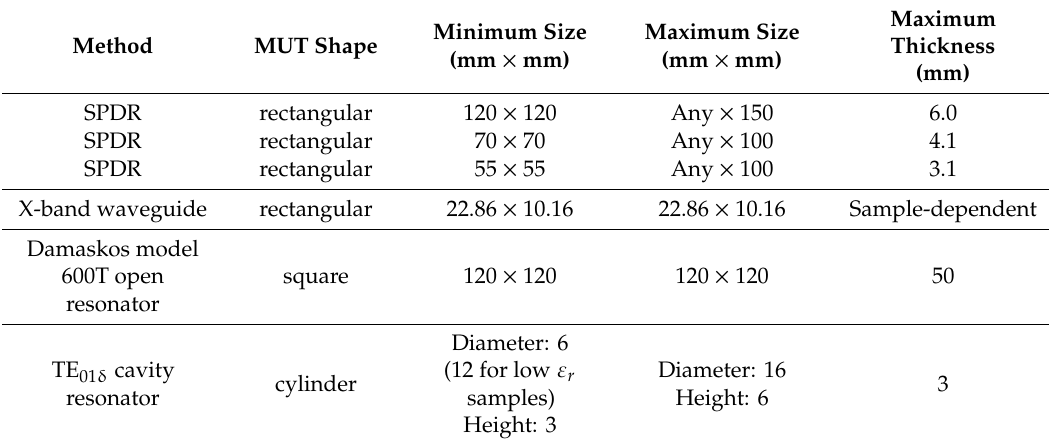
Table 2. Required shape and size of MUT for measurements using SPDRs, X-band waveguide,